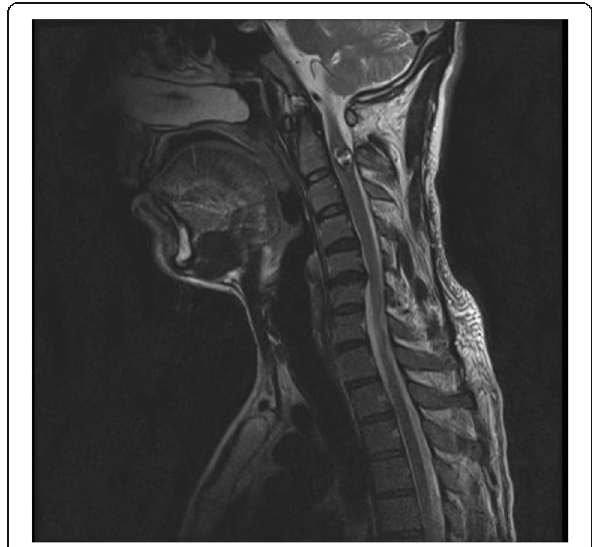
Fig. 1 MRI of the patient showing cavernoma